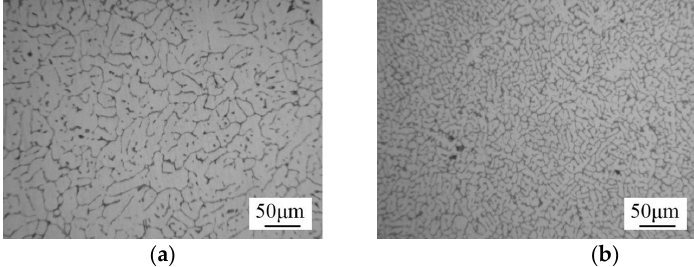
Figure 7. Microstructure of the weld center of as-welded joints under different heat inputs: ( a ) plate No. 1, 7126.9 kJ; ( b ) plate No. 8, 3947.3 kJ.